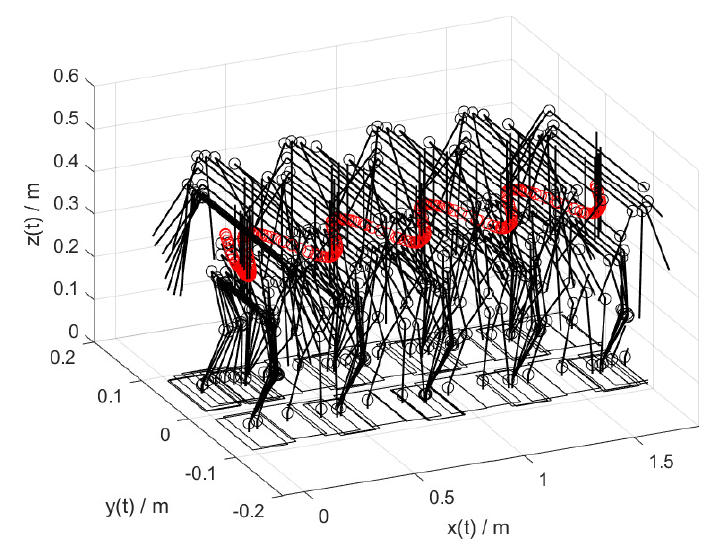
Figure 5. Animation of planned gait.